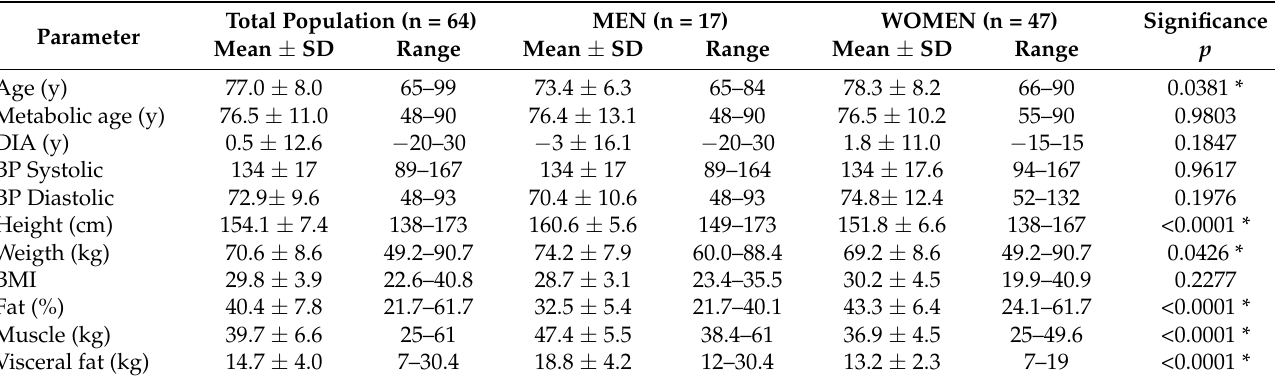
Table 2. Characteristics of the participants in the